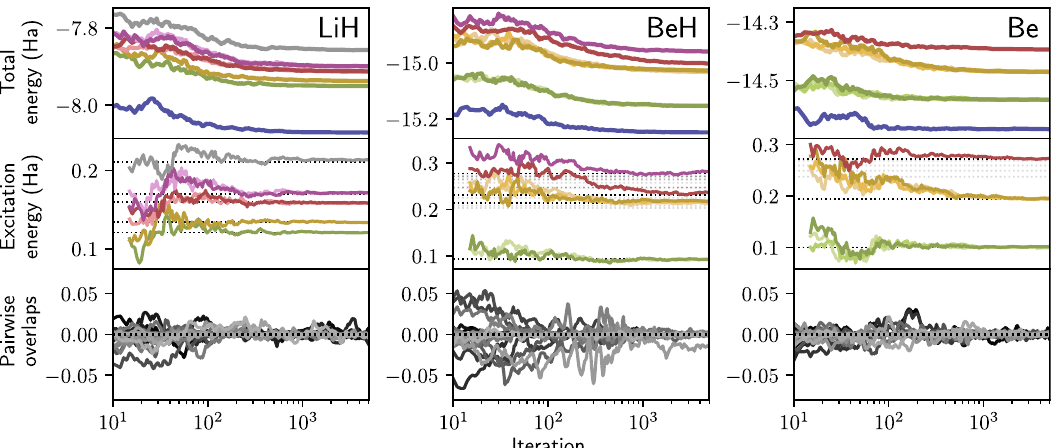
Fig. 2 | Optimizing low-lying excitedstates for small molecules. Several excited statesofLiH,BeH,andBeareapproximated.Theconvergenceofthetotalenergies (upper row), excitation energies (middle row), and the pairwise overlaps between the wavefunctions (bottom row) are shown. For degenerate states, multiple ansatzes attain the same energy. Dotted horizontal lines are excitation energies